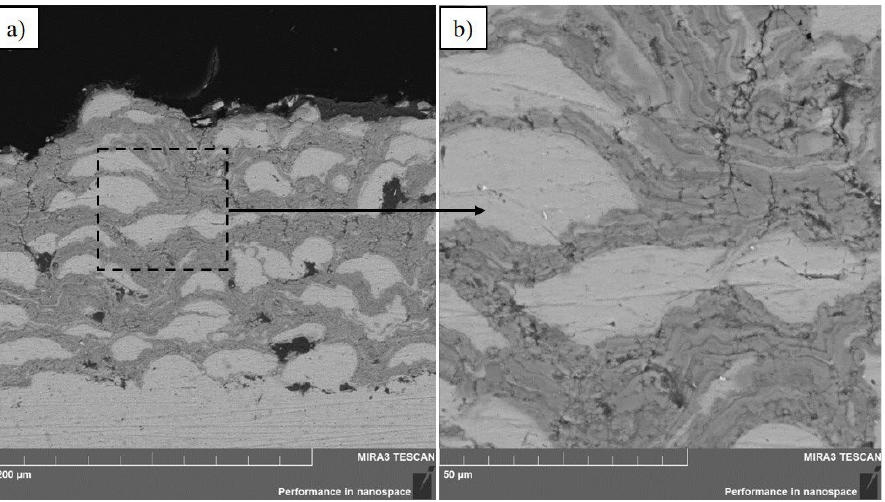
Figure 4. Cross-sectional microstructure of Ti2 coating. Microstructure of ×1000 ( a ) and ×3000 ( b ).